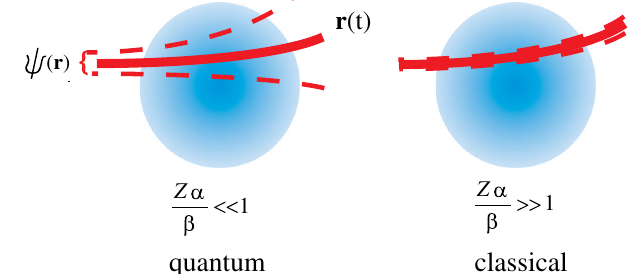
FIG. 1. Comparison of diffractive wave packet divergence [ ψ ð r Þ , dashed line] and classical particle deflection [ r ð t Þ , solid line] in the quantum (left) and classical cases.